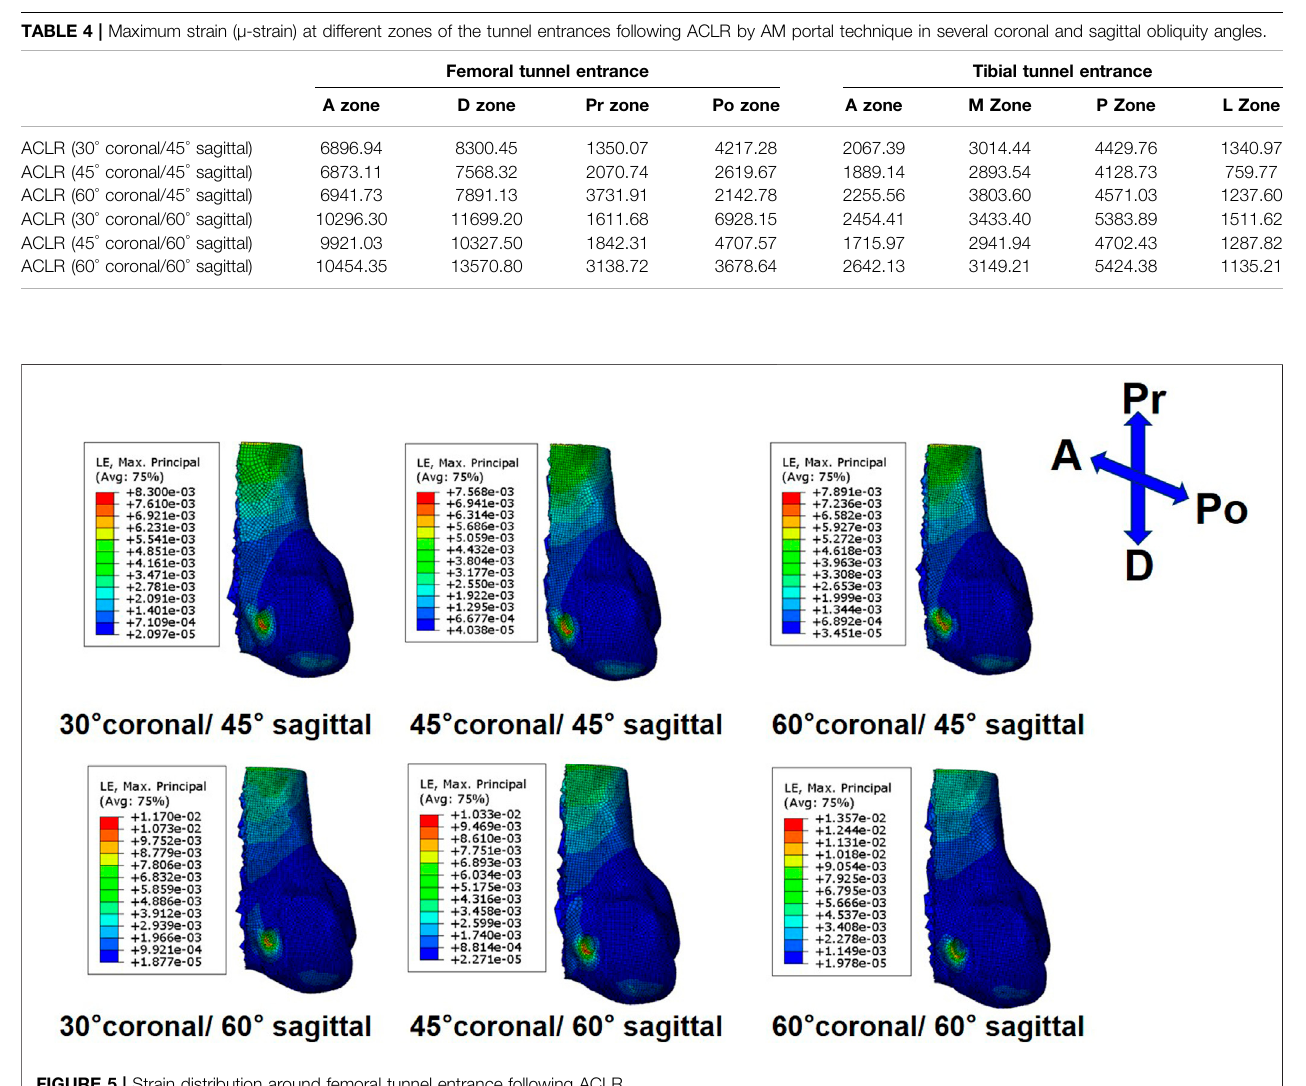
FIGURE 5 | Strain distribution around femoral tunnel entrance following